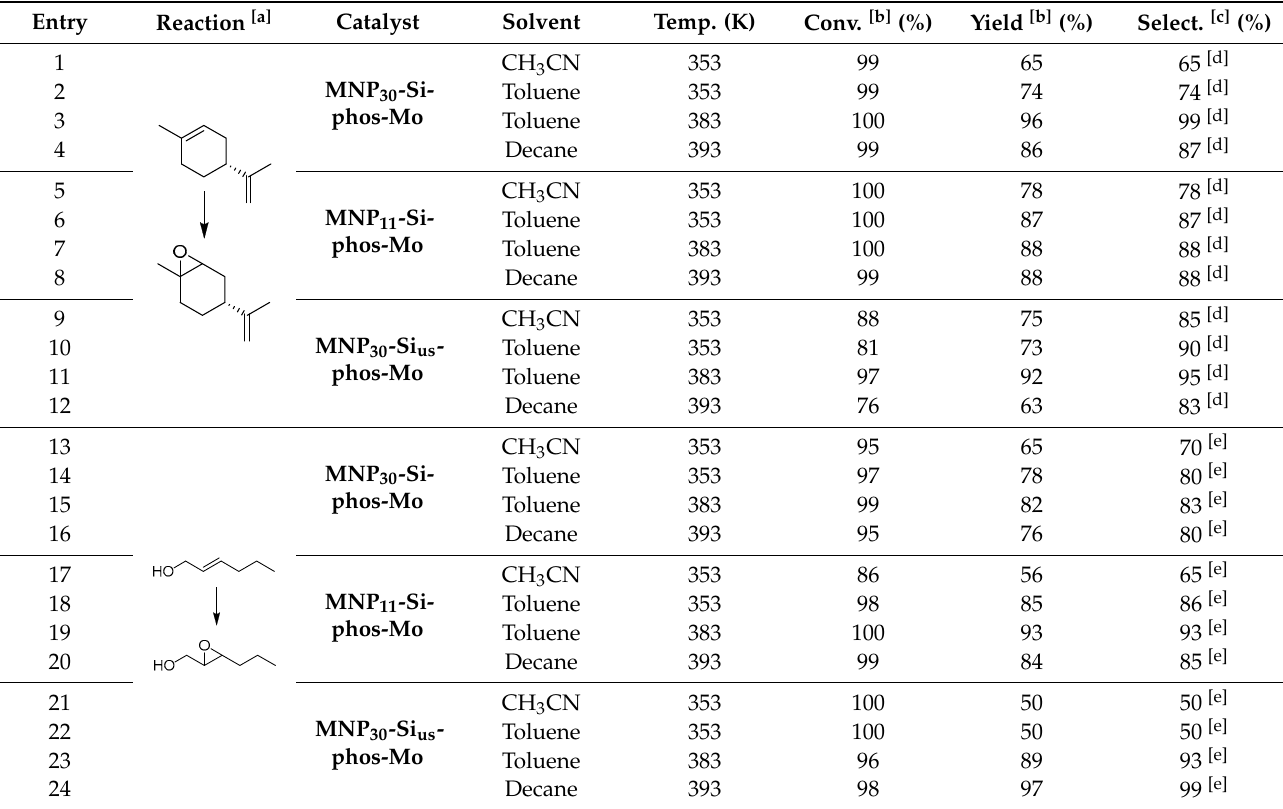
Table 2. Catalytic epoxidation of R -(+)-limonene and trans -hex-2-en-1-ol using MNP 30 -Si-phos-Mo, MNP 11 -Si-phos-Mo, and MNP30-Si us -phos-Mo as catalysts.